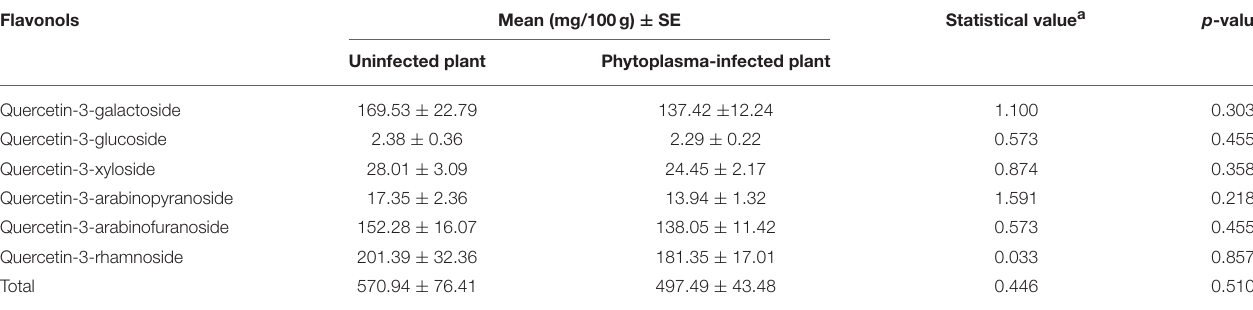
TABLE 2 | Concentration ( ± SE) of flavonols in uninfected and phytoplasma-infected cranberry plants.